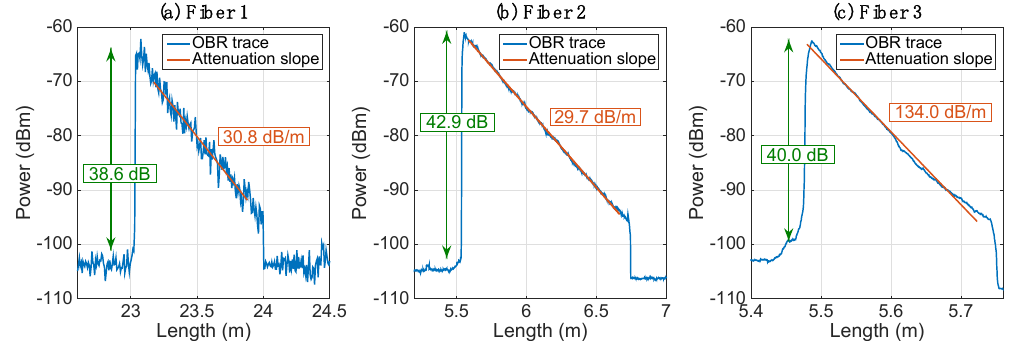
Figure 4. Scattering traces measured on the OBR instruments for three different MgO-NP fibers; data show the estimation of gain and two-way losses. ( a ) Fiber M01 used in [18]; ( b ) fiber M01 used in [19]; ( c ) fiber R04.